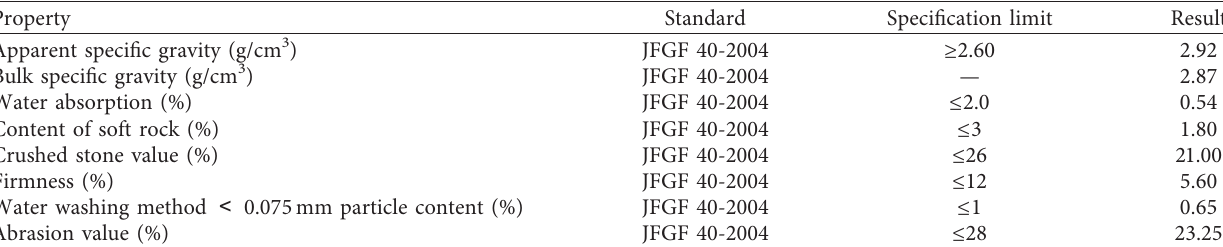
Figure 1: Microstructures of the nanoclays: (a) OMMT A, (b) OMMT B, and (c) LDH. Table 2: Physical properties of the coarse